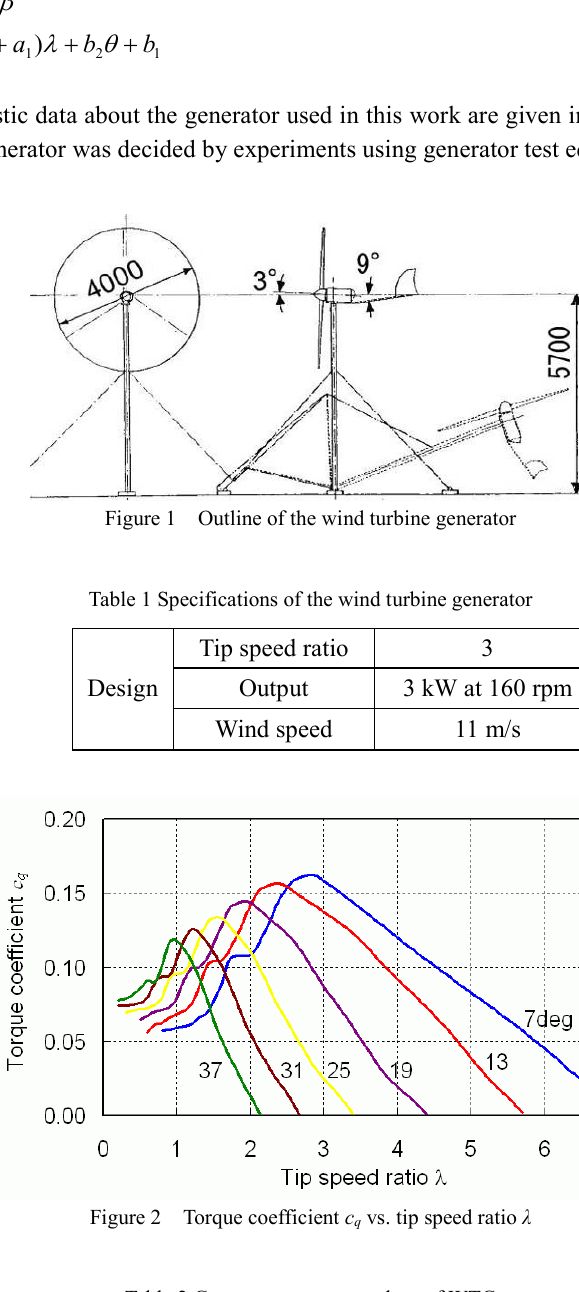
Table 2 Constant parameter values of